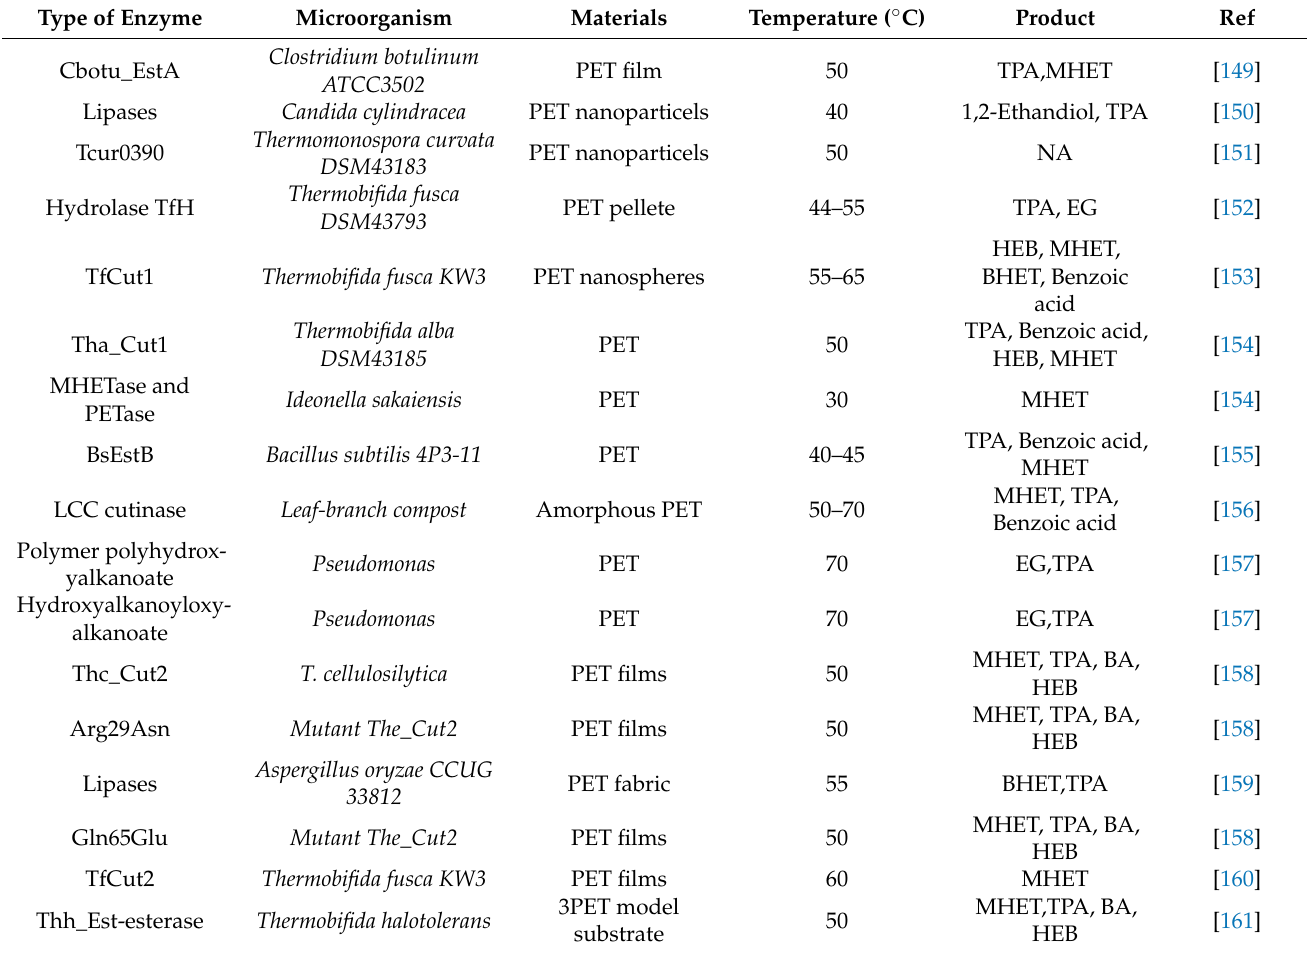
Table 3. Summary enzymatic degradation of PET with a different type of